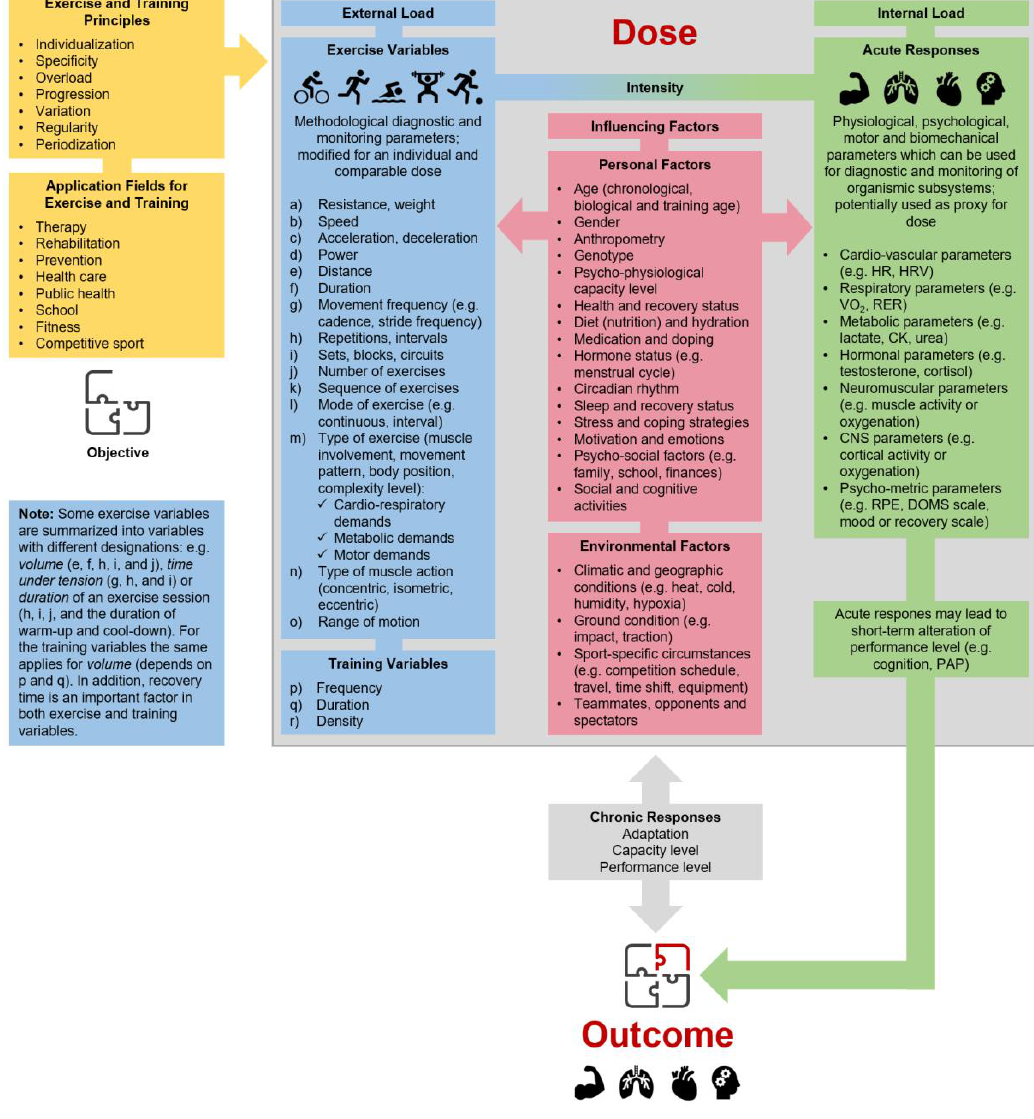
Figure 1. Individual physical exercise and training prescription are based on specific objectives and the respective context in the varying fields of application, as well as principles for the programming and monitoring of physical exercise and training. The dose–outcome relationship depends on a multitude of factors, such as factors of external and internal load and influencing factors. HR: heart rate, HRV: heart rate variability, VO 2 : oxygen uptake, RER: respiratory exchange ratio, CK: creatine kinase, CNS: central nervous system, RPE: rating of perceived exertion, DOMS: rating of delayed onset muscle soreness, PAP: post-activation